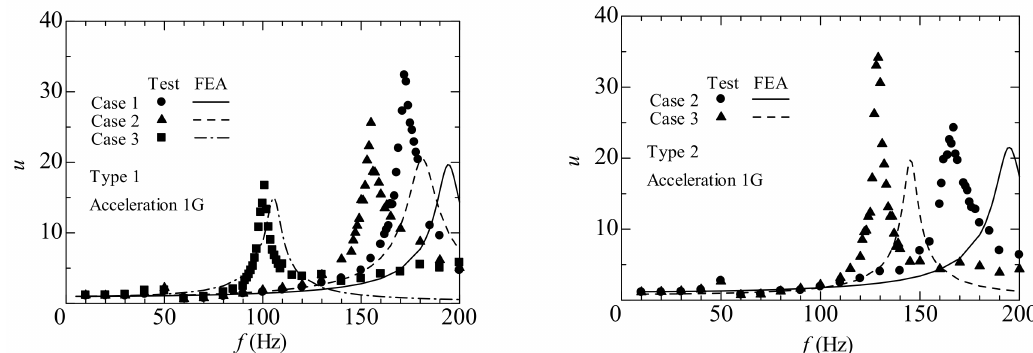
Figure 4. Normalized displacement versus frequency for the energy harvesting devices (Types 1 and 2).